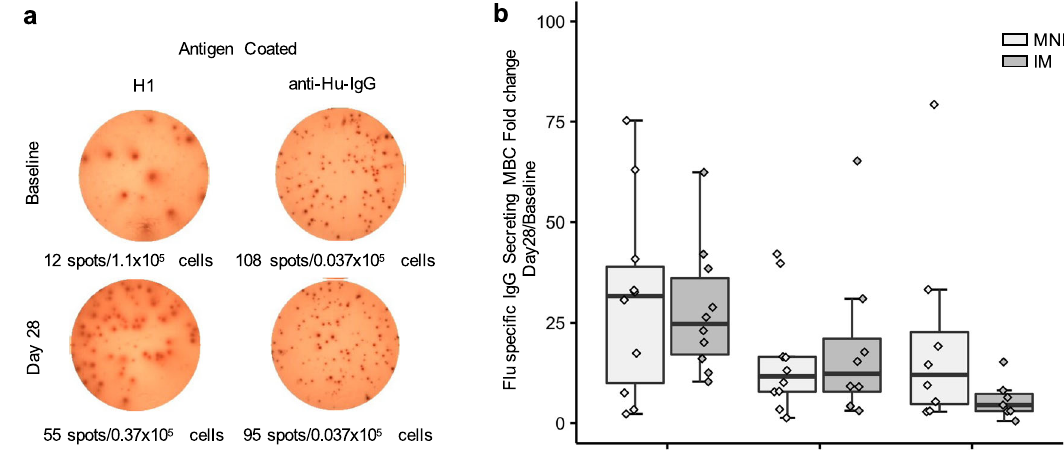
Fig. 8 In fl uenza-speci fi c IgG-secreting memory B cells (MBCs) after vaccination. a Representative ELISpot showing H1 protein and IgG protein-speci fi c memory B cells at baseline and Day 28 post vaccination. b Fold change of in fl uenza-speci fi c IgG-secreting Memory B Cells (MBCs) responses at Day 0 and Day 28 by vaccine delivery group (MNP: n = 10; IM: n = 11). The box portion of the plot represents the interquartile range (IQR: 25th percentile, median, and 75th percentile) of the data. Error bars represent smallest and largest values within 1.5 times IQR. IM, IIV by intramuscular route; MNP, IIV by microneedle